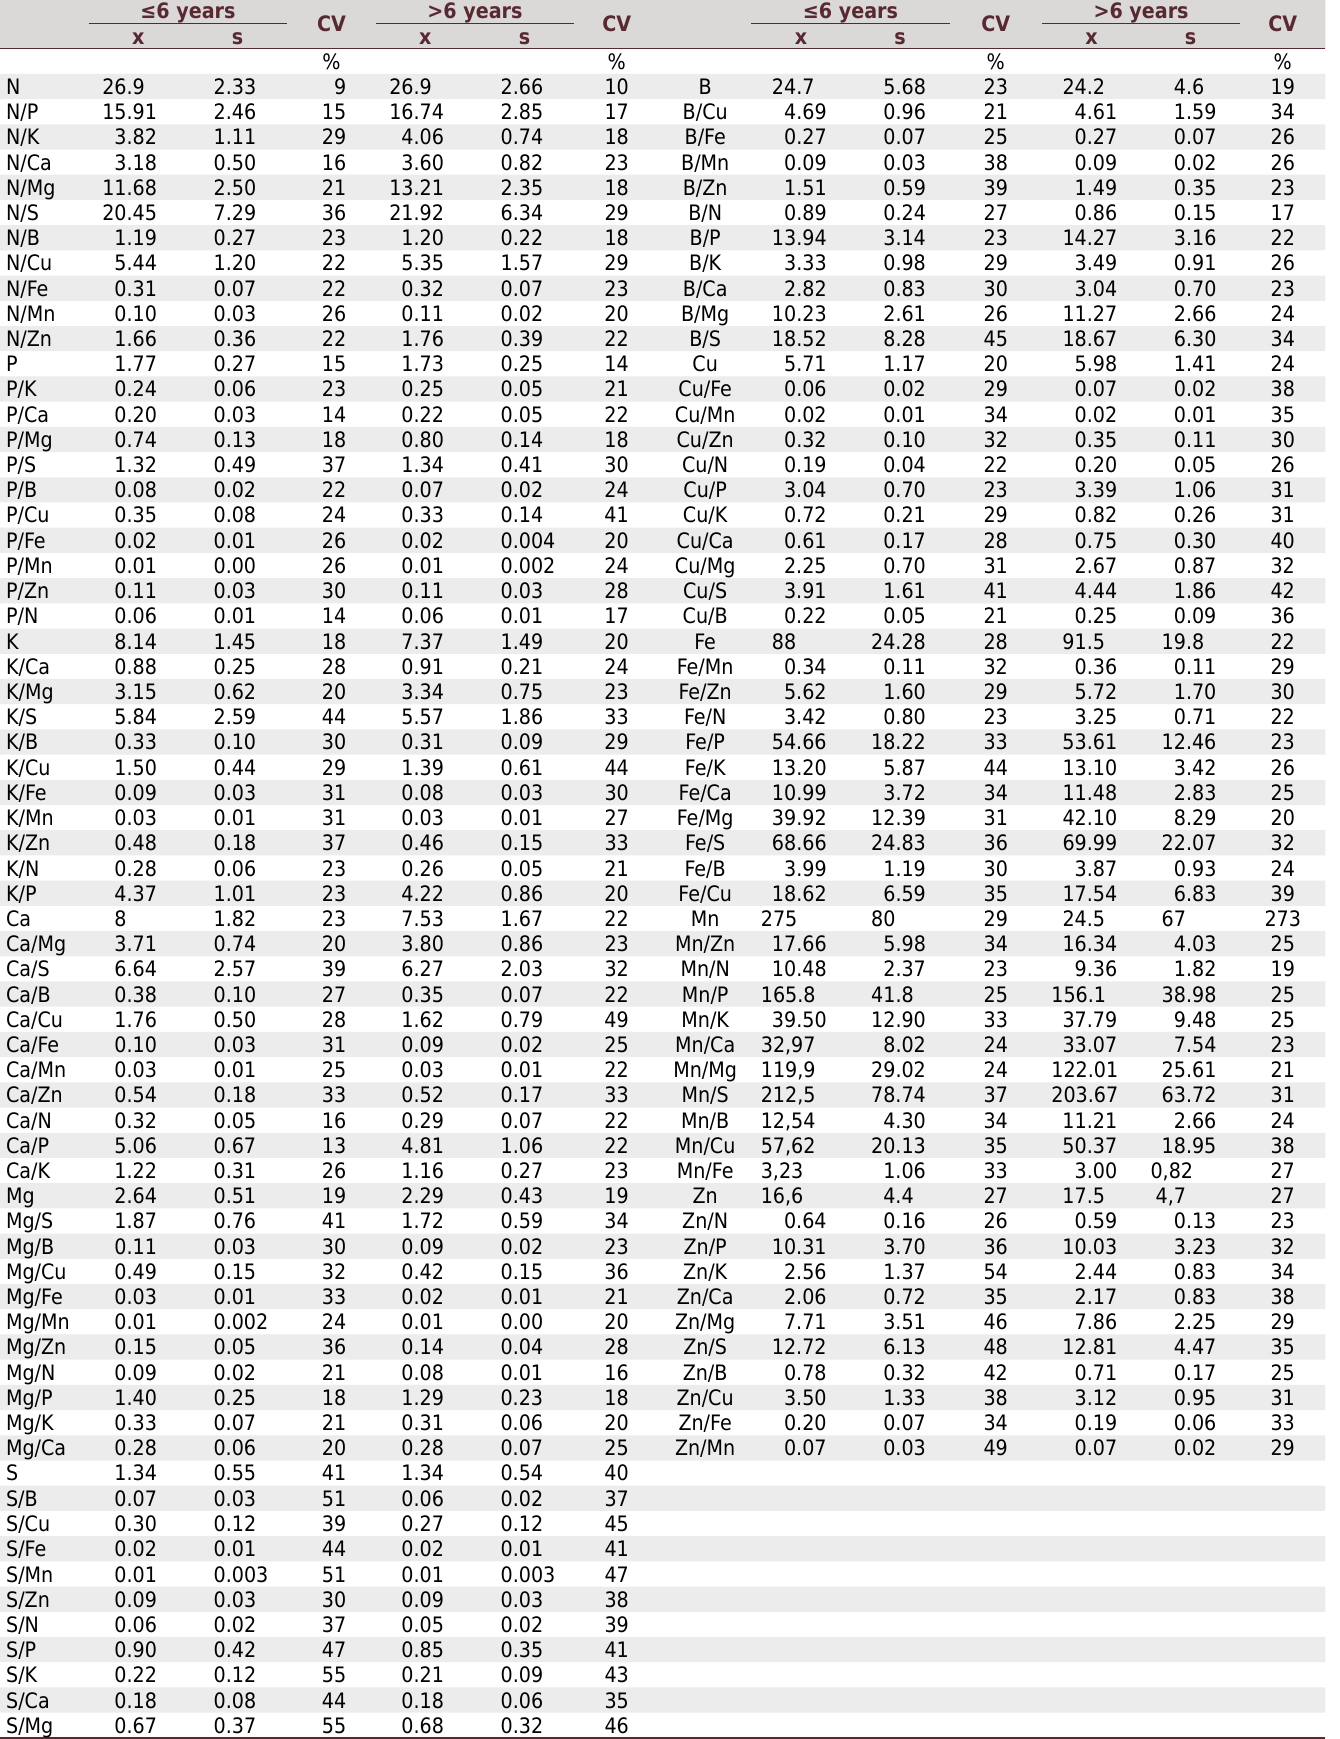
Table 3. Average (x), standard deviation (s), and coefficient of variation (CV) of the macro (g kg -1 ) and micronutrients (g kg -1 ) contents and nutritional relationships of reference populations with young (≤6 years after planting) and adult (>6 years after planting) palms ≤6 years